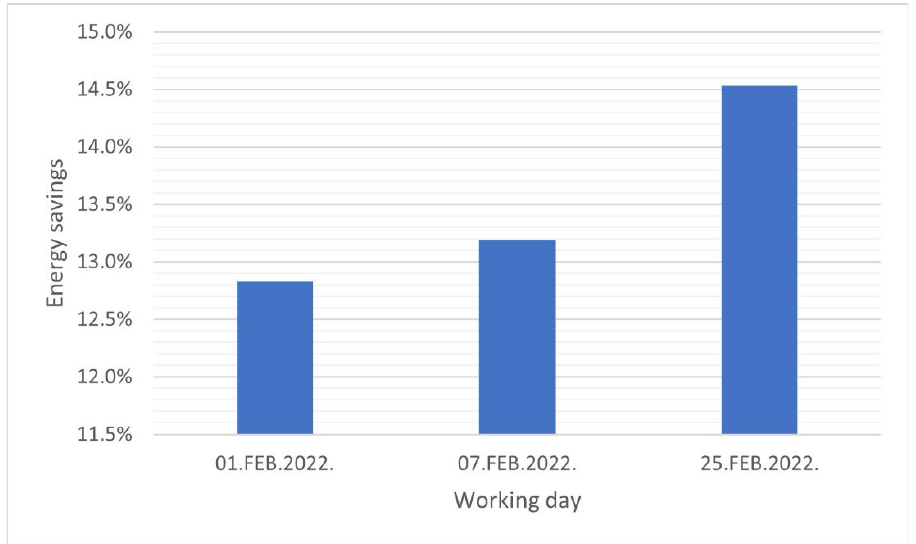
Figure 9. Reduction in the forklifts’ energy consumption.